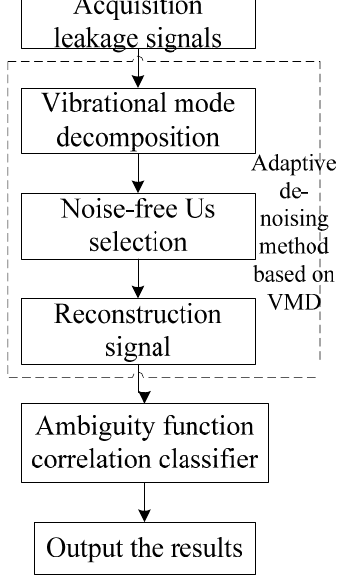
Figure 4. Flowchart of the small leakage detection method.